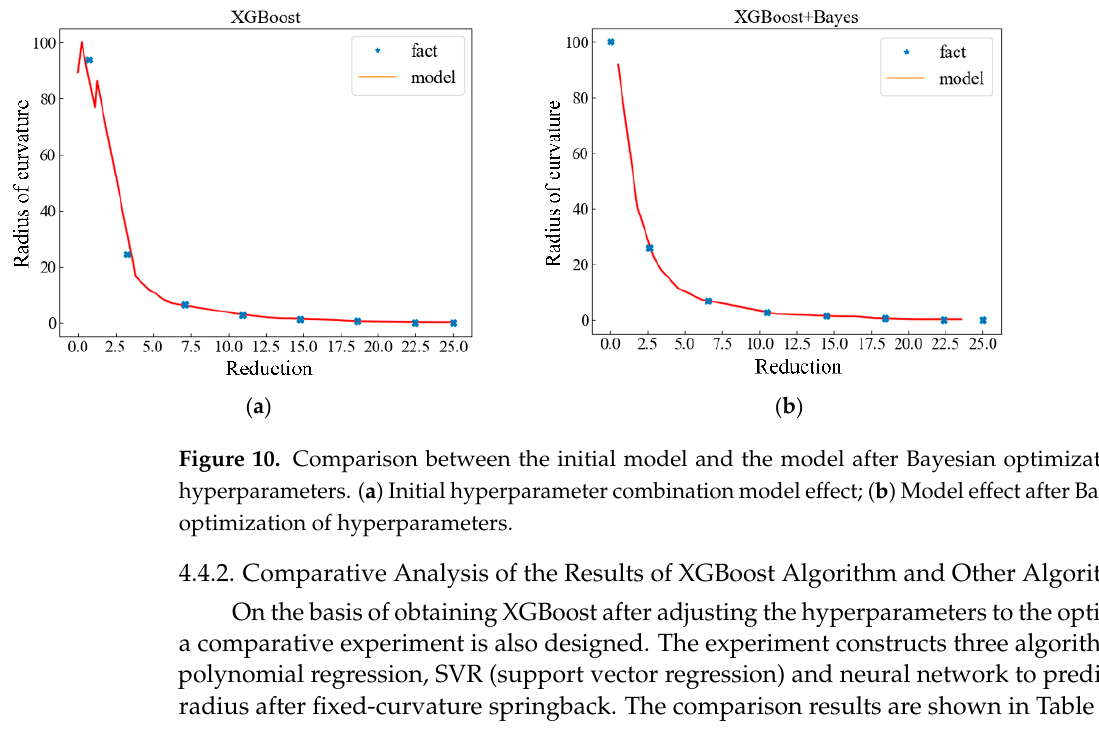
Table 6. Prediction and evaluation index of the algorithm for the radius of curvature after spring- back of fixed-curvature forming based on XGBoost. Table 7. Prediction and evaluation indicators of other regression models and XGBoost models. MSE Polynomial